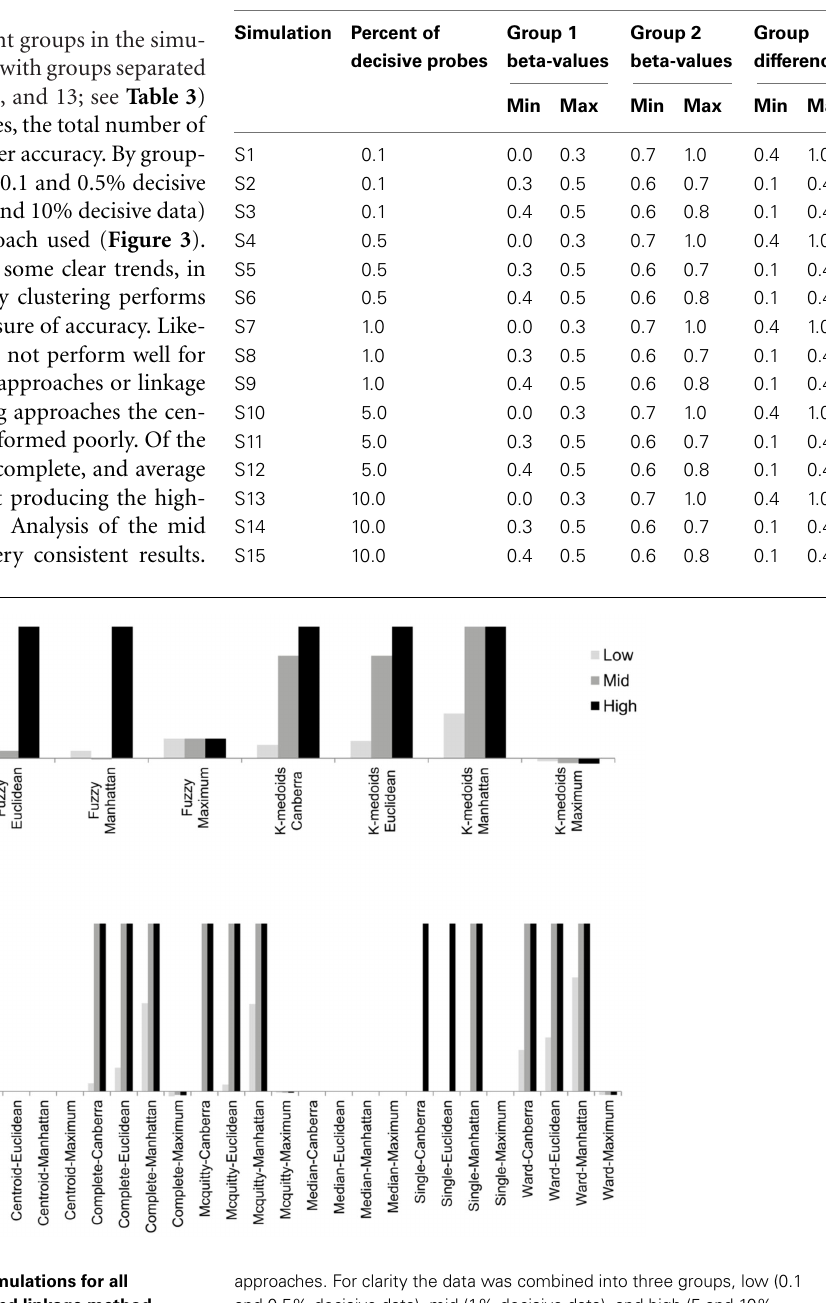
Table 3 | Ranges of simulated values for each of 15 simulated data.